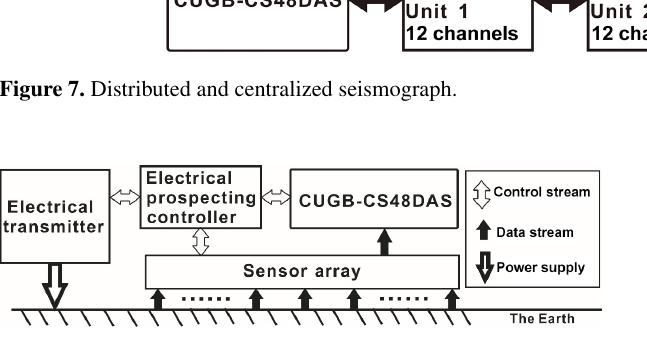
Figure 8. Extension of geophysical electrical